Question: In one sentence, what is this figure communicating?
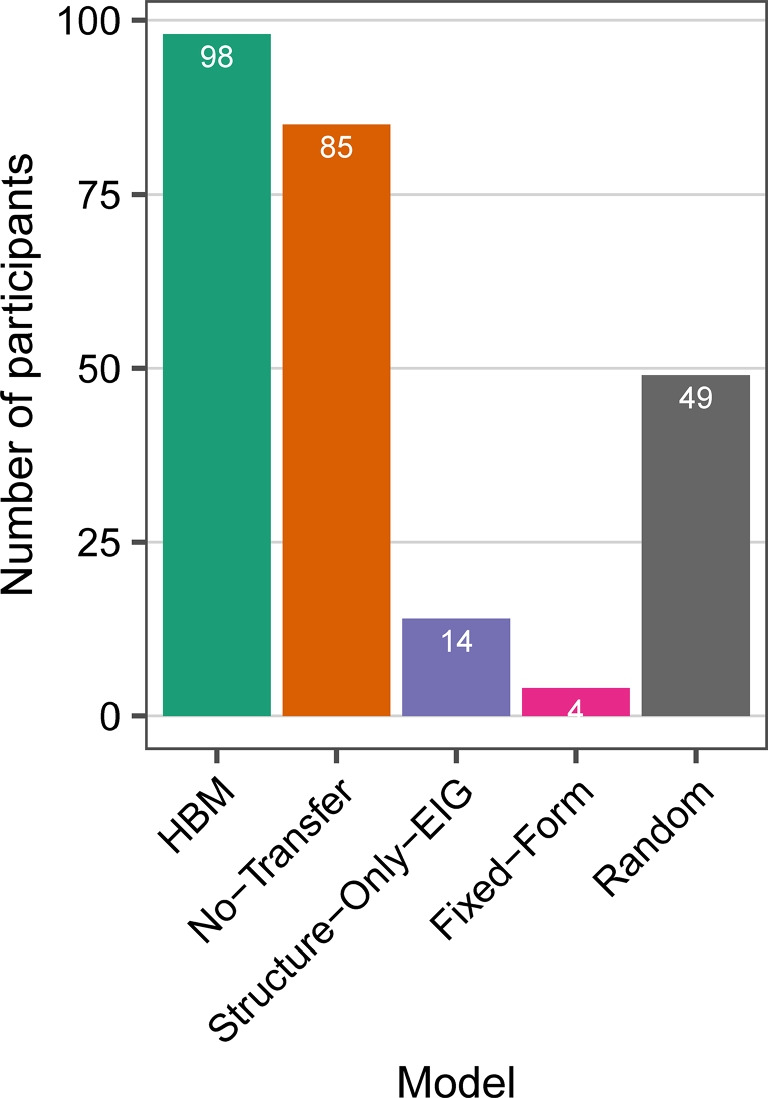
Answer: Best model for individual participants (Experiment 2). Each model’s bar counts the number of participants whose transfer task interventions were best-predicted by that model, i.e., assigned the highest mean predictive likelihood by that model compared with all other models. The comparison was performed on a per-participant basis and using cross-validation and marginalization over priors. Our Hierarchical Bayesian Model (HBM) was the best predictor for the highest number of participants compared with the ablation models (No-Transfer, Structure-Only-EIG (Expected Information Gain), Fixed-Form) and a random baseline